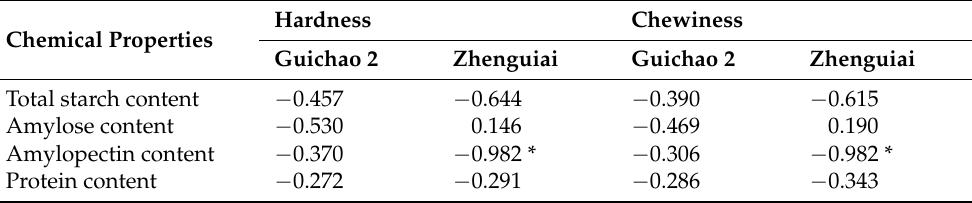
Table 5. Pearson’s correlation coefficients between hardness and chewiness of cooked rice noodles with total starch, amylose, amylopectin, and protein contents in milled rice flour in two rice cultivars, Guichao 2 and Zhenguiai, grown in 2020 and